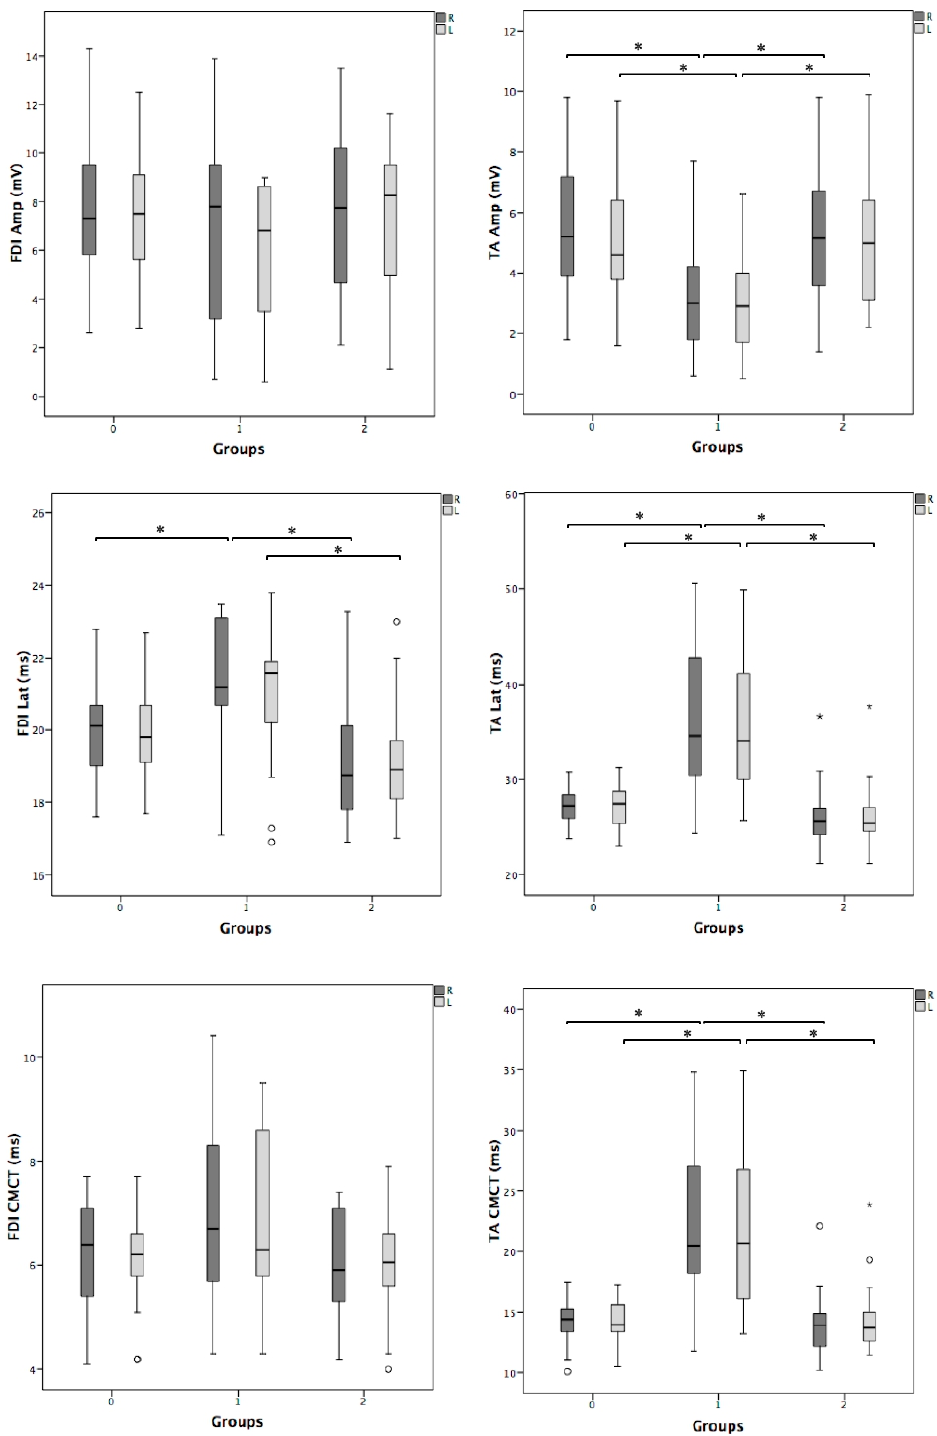
Figure 2. Box-plots of the motor-evoked potentials (MEPs): intergroup analysis (0 vs. 1 vs. 2). Group 0: healthy controls; Group 1: patients with signs of pyramidal tract dysfunction including motor deficit; Group 2: patients with signs of pyramidal tract dysfunction without motor deficit. Amp = MEP amplitude; CMCT = central motor conduction time; FDI = first dorsal interosseous muscle; L = left; Lat = MEP latency; R = right; TA = tibialis anterior muscle; whiskers = interquartile range; * = p < 0.05.